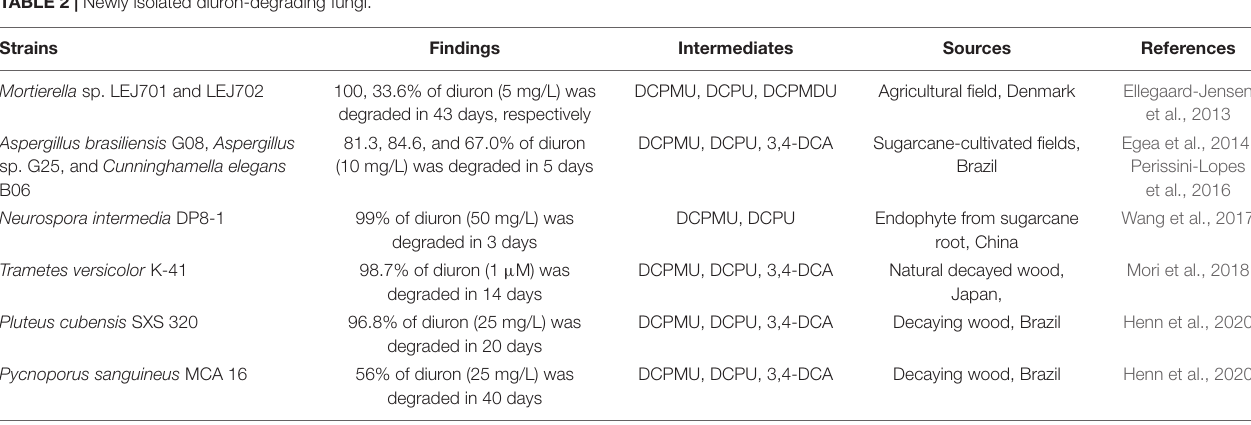
TABLE 2 | Newly isolated diuron-degrading fungi.